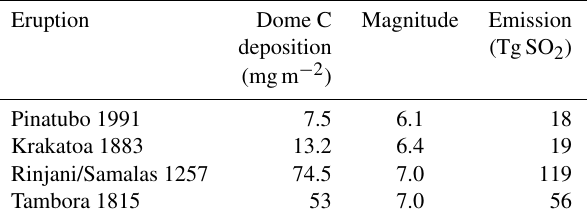
Table 1. Identified sulfate peaks in Dome C with magnitude and estimated emission (Toohey and Sigl, 2017). Eruption Dome C Magnitude Emission deposition